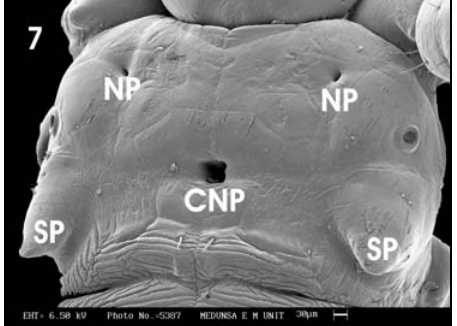
host (Fig. 9). This grasping was further aided by a distotibial thumb, as well as a distotib- ial pad-like structure. This seemingly acts as a shock absorbing pad. Between the distotib- ial pad at the base of the tarsal claw, a small structure was found. This structure strongly resembles the spiked empodium found on the claws of Pseudolynchia canariensis , a common ectoparasite of pigeons and wild birds (Green & Turner 2001) and as far as could be established, it has not been record- ed in H. bufali until now (Fig. 10). Two mesothoracic spiracles were noted (Fig. 11), each situated laterally on the left and